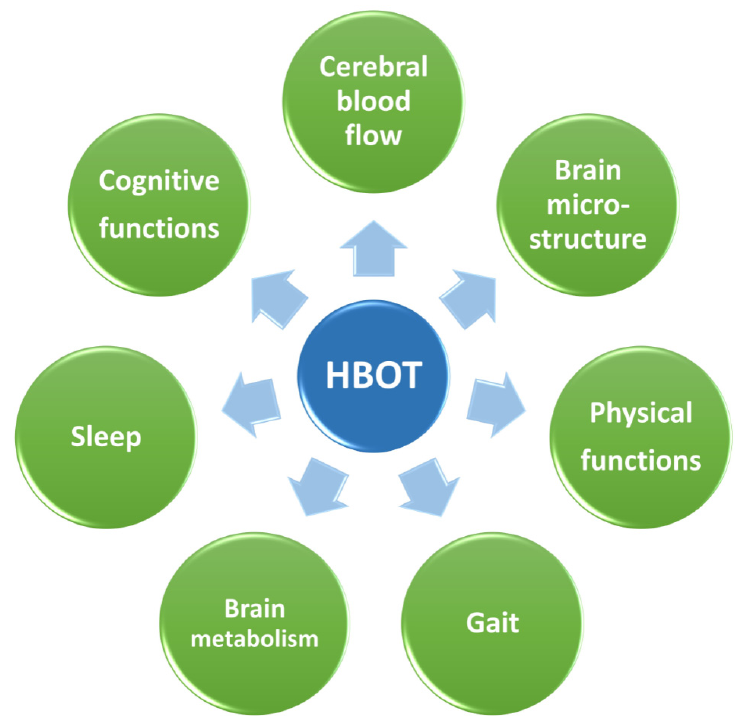
Figure 1. HBOT improves brain function. HBOT has been shown to improve cerebral blood flow, brain metabolism, and brain microstructure, leading to improved cognitive functions, physical functions, sleep, and gait.